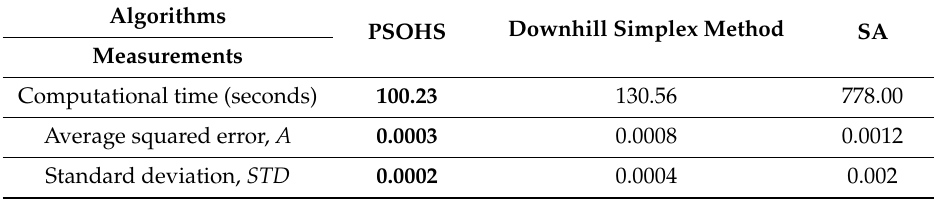
Table 2. Comparison between PSOHS, the downhill simplex method, and Simulated Annealing (SA) in estimating six parameters for isoleucine in terms of computational time, average squared error, and standard